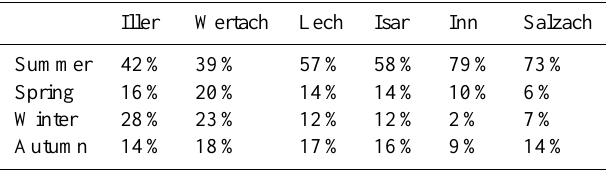
Table 2. Seasonal distribution of flood events (percentages refer to the individual outer-Alpine river sections) in the Bavarian Foreland for the period from the 14th century to